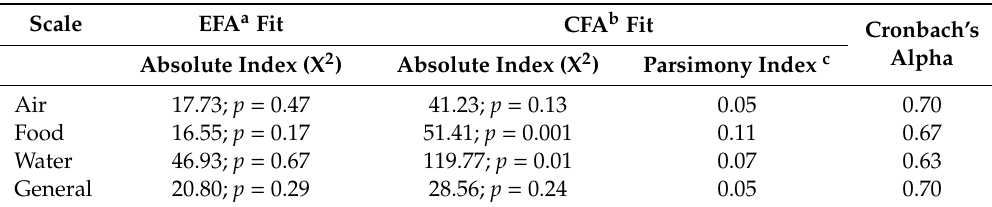
Table 3. Exploratory and confirmatory factor analysis and Cronbach’s alpha for Air, Food, Water, and General environmental health scales.